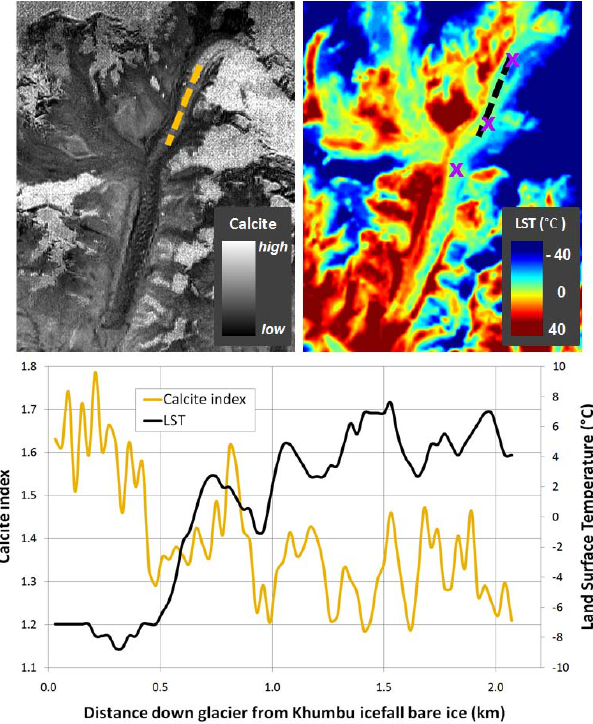
Fig. 7. Ngozumpa glacier ASTER L1B calcite abundance (top left) is compared to Landsat TM derived supraglacial temperatures (top right). The plot beneath the images displays calcite abundance vs. LST transect values across the upper Ngozumpa ablation area. Note that calcite rich areas correspond with higher glacier surface tem- peratures.